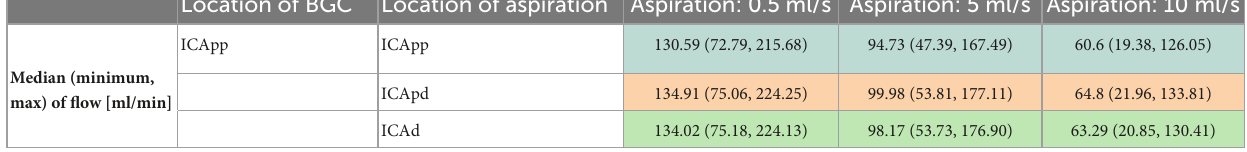
TABLE 5 Average values of median MCA flow (ml/min) during the active retrieval phase.